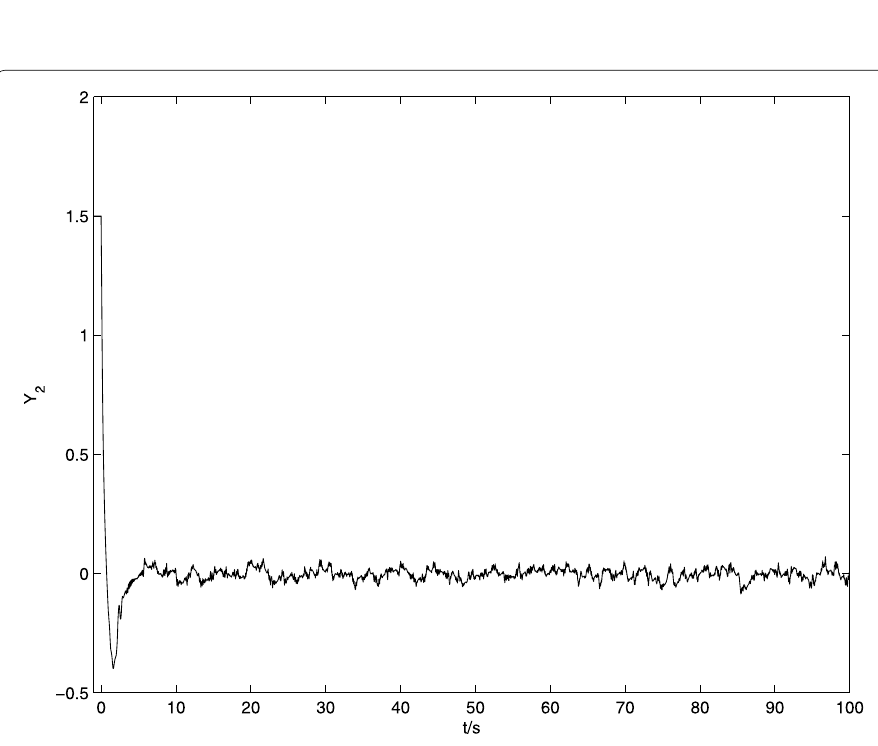
Figure 4 Time response of output variable Y 2 ( t ) of the Lurie